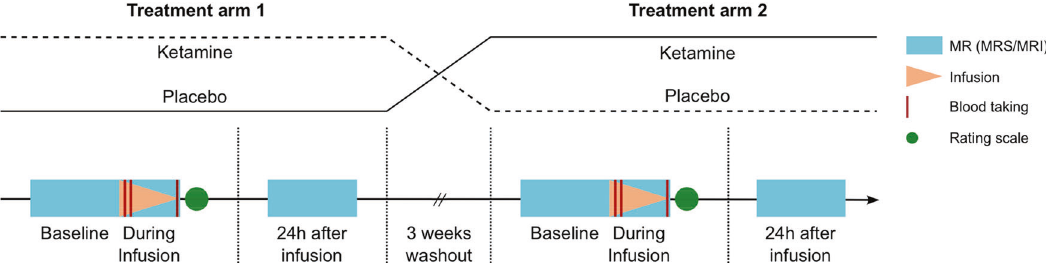
Fig. 1 Study design. The experimental procedure consisted of two consecutive days per treatment arm. On day 1 (infusion day), participants underwent MR scanning before and during S-ketamine or placebo infusion. Blood samples were obtained 8, 13 and 48 min after the beginning of the infusion. On day 2 (24 h after infusion), MR scanning was repeated with the same neuroimaging measurements. Additional HR rsfMRI was acquired on all measurement days, unrelated to this analysis. Treatments were crossed-over with a washout period of 3